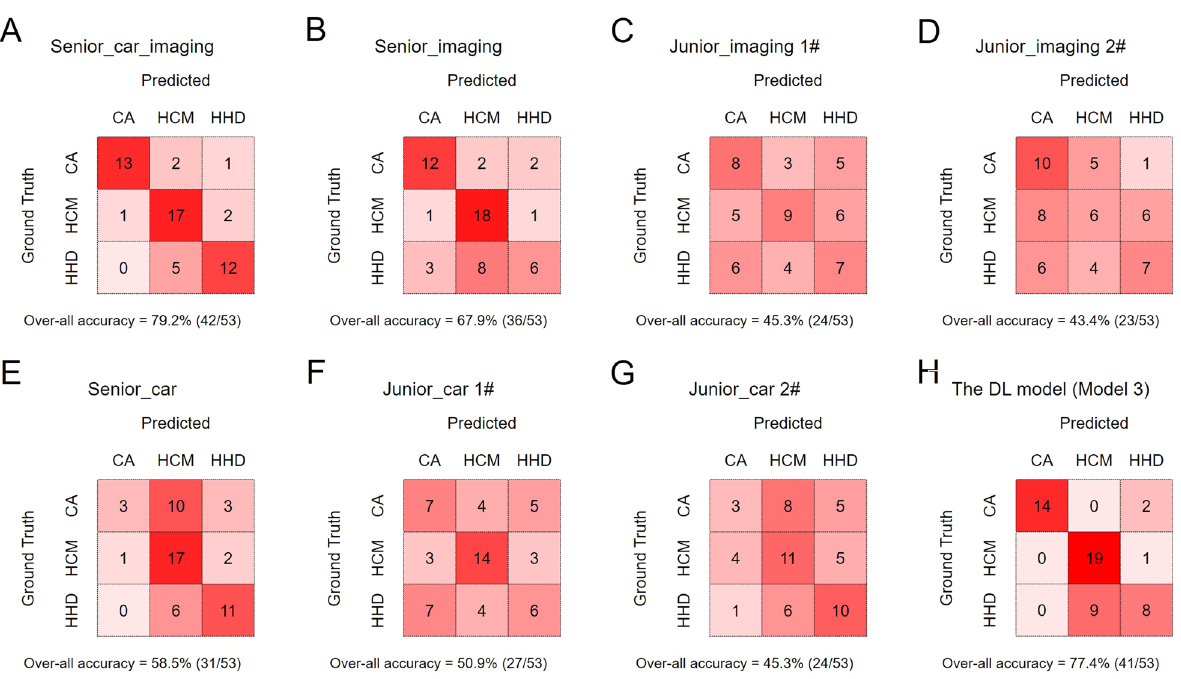
Italic indicates the results of DL model 3 as the reference, and report if the performance of any other rater (radiologists or cardiologists) had any difference from DL model 3